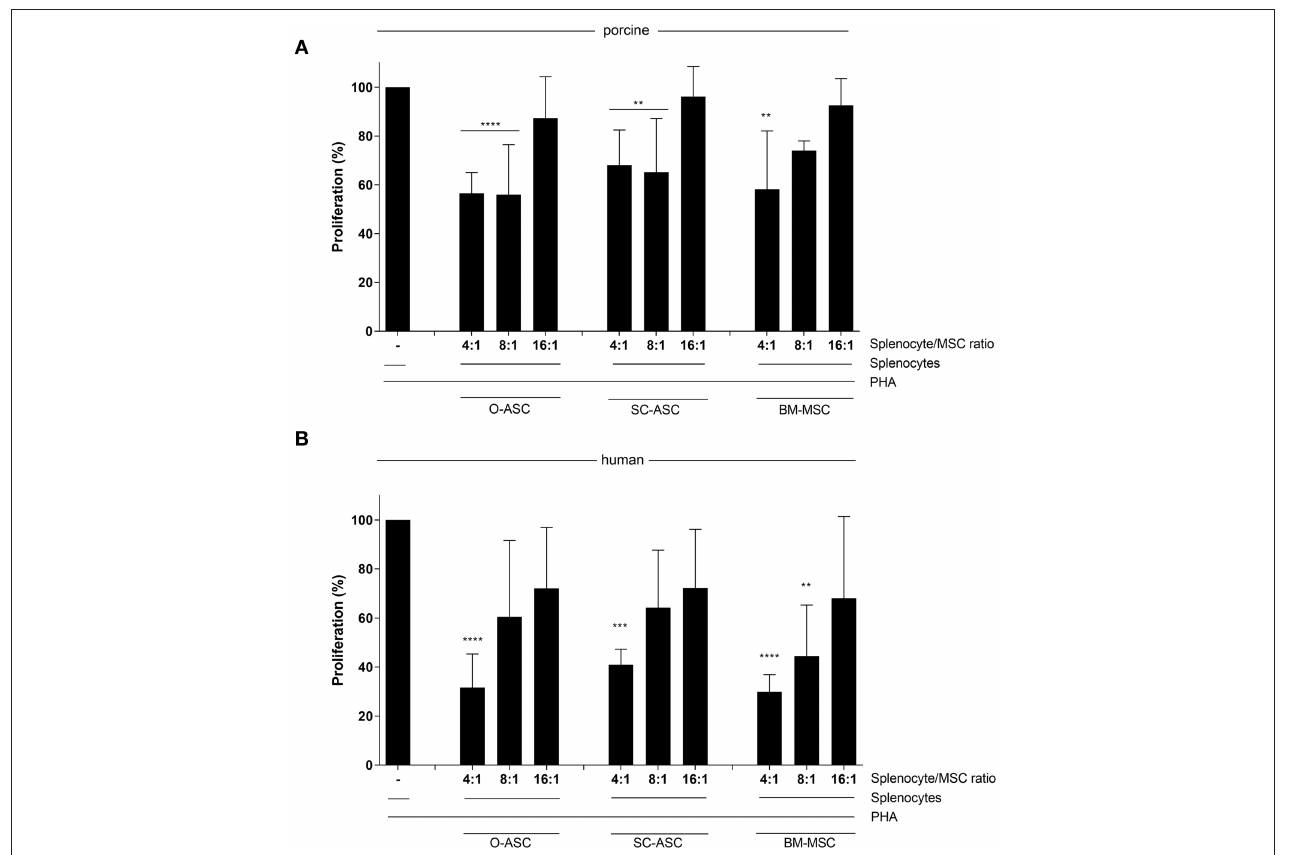
FIGURE 5 | Immunosuppressive function. Mixed lymphocyte reaction assays (MLR) were performed to assess the immunomodulatory potential of the three cell lines (O-ASC, SC-ASC, and BM-MSC) head-to-head of both porcine (A) and human (B) origin. Yorkshire splenocytes were stimulated with PHA and co-cultured with the different cell lines for 3–5 days. Error bars = SD. Expressed as percentage proliferation in relation to positive control. Two-way ANOVA with Tukey post-test. ** p < 0.01, *** p < 0.001, **** p < 0.0001 vs. control (splenocytes +